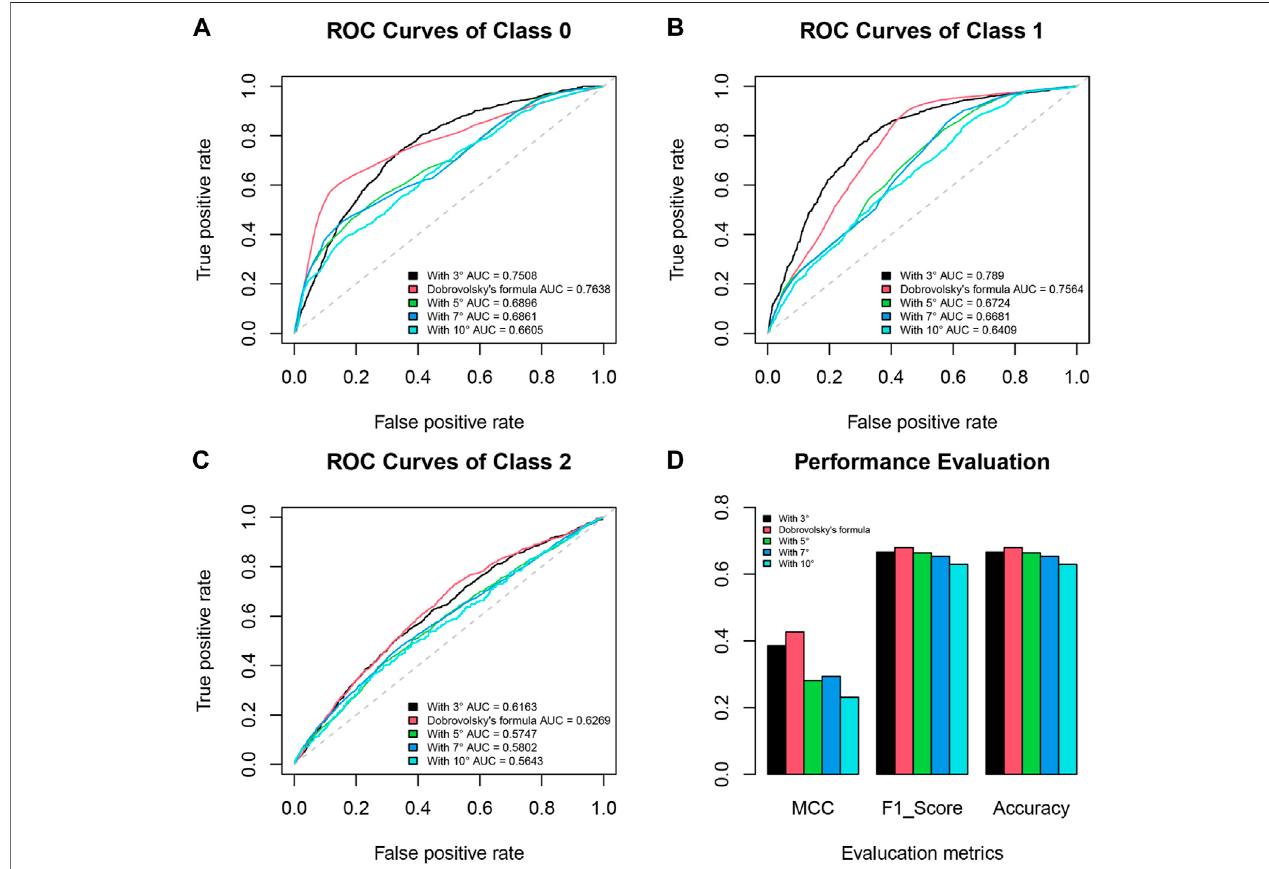
FIGURE5| Receiveroperatingcharacteristic(ROC)curvescomparingmodelperformancewithdifferentspatialwindowradii(3 ° ,Dobrovolsky ’ sformula,5 ° ,7 ° ,and 10 ° for (A) class 0, (B) class 1, and (C) class 2. (D) Bar plot curves of Matthews correlation coef fi cient (MCC), F1 score, and accuracy.